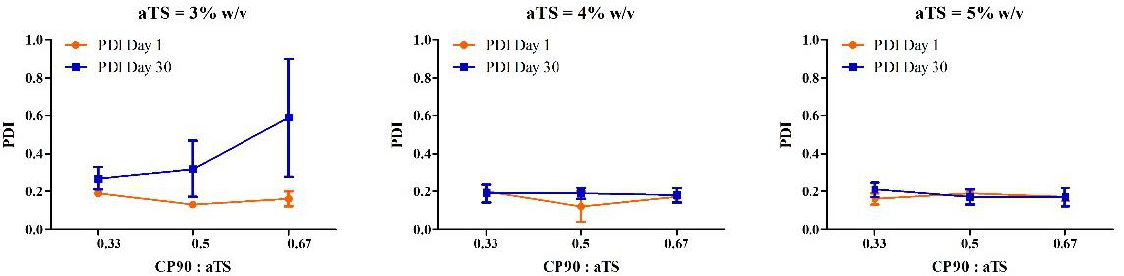
Figure 3. Descriptive plots for the effect of the amount of αTS and CP90:αTS ratio on the PDI when the concentration of αTS is 3%, 4% and 5%.